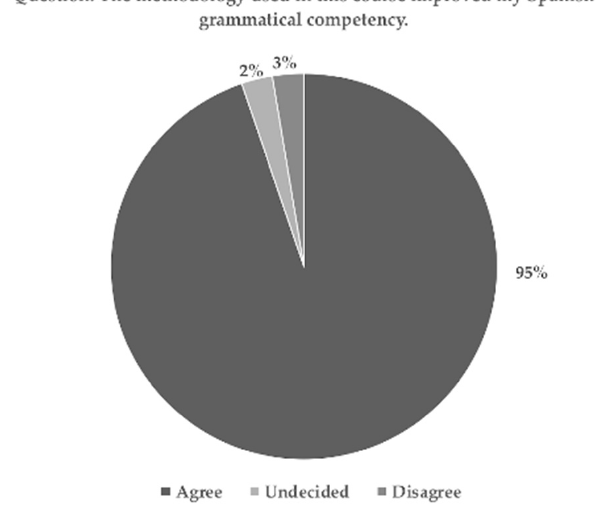
Figure 12. Students’ opinions on the relevance of the implemented methodology for developing their grammatical competency in Spanish.